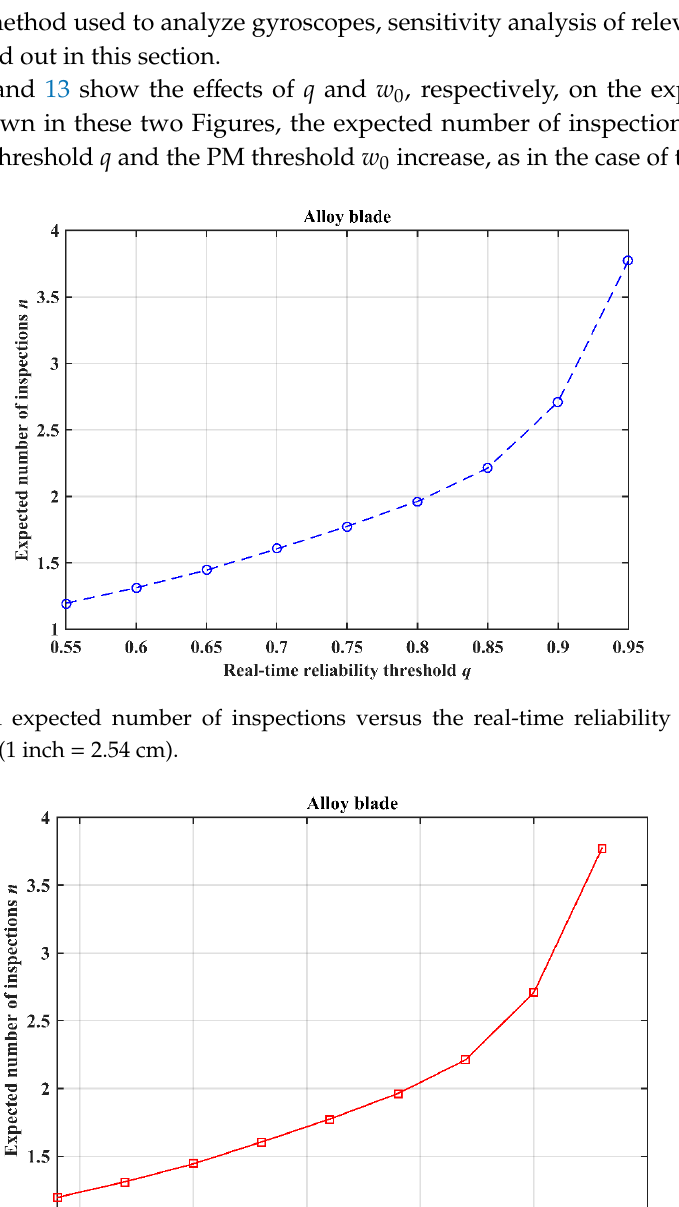
Figure 11. The relationship between the expected total cost rate 𝐶 (cid:3028)(cid:3049)(cid:3032)(cid:3045) , the PM threshold 𝑤 (cid:2868) and the real-time reliability threshold 𝑞 .